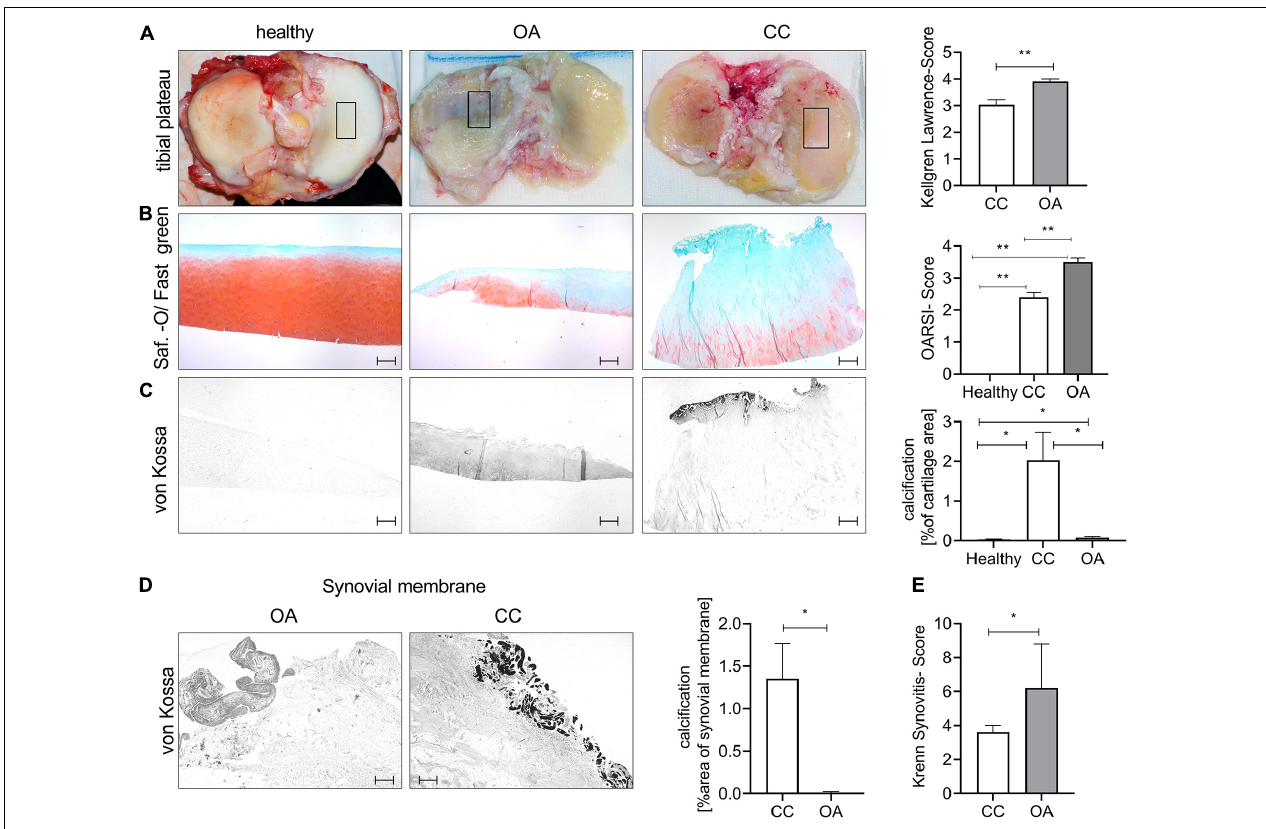
FIGURE 1 | Chondrocalcinosis (CC) cartilage shows less severe histological cartilage destruction. (A) Representative images for the tibial plateau of healthy controls, as well as osteoarthritis (OA) and CC patients (the black square indicates the main loading area and region of sampling). The quantification of radiological OA was performed using the Kellgren–Lawrence Score [CC (3.0 ± 0.19), N = 27; OA (3.9 ± 0.09) N = 11, t -test p = 0.0075]. (B) Representative pictures of cartilage sections stained with Safranin-Orange (middle). Quantification of histological OA severity in the tested OA and CC cohorts [healthy: 0 ( N = 6), CC: 2.4 ± 0.14 ( N = 24) and OA: 3.5 ± 0.13 ( N = 10), one-way ANOVA: F (2,37) = 71.69, p < 0.0001]. (C) Representative pictures of von Kossa-stained cartilage sections. Quantification of cartilage calcification from von Kossa staining [healthy: 0.03 ± 0.01 ( N = 6, n: 1–2), CC: 2.02 ± 0.7 ( N = 27, n: 1–2), and OA: 0.07 ± 0.02 ( N = 11, n: 1–2),